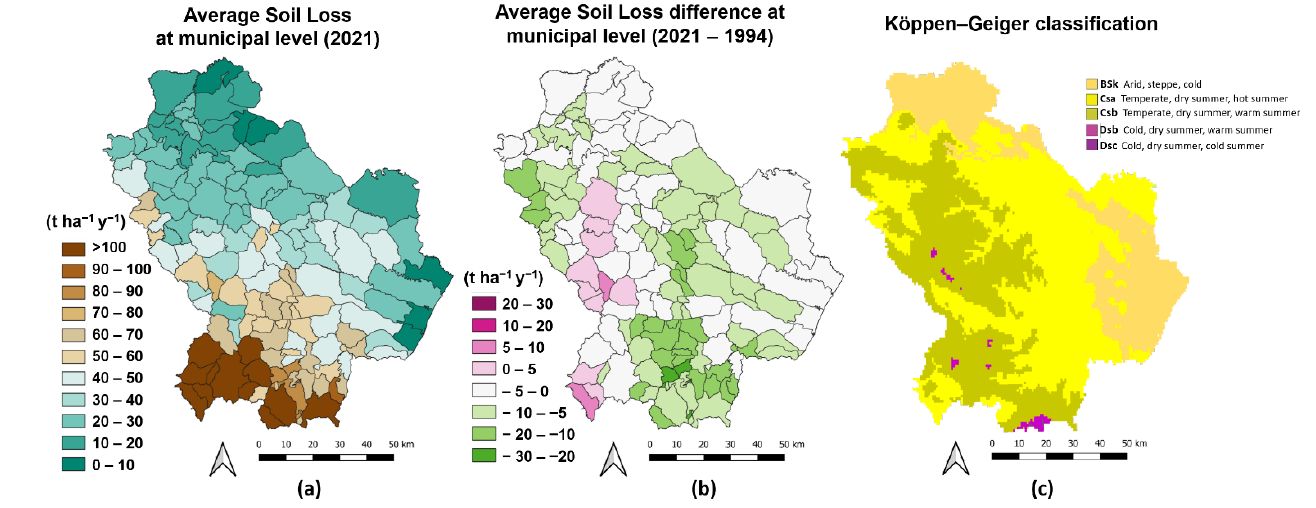
Figure 8. Soil loss rates computed at the municipal level for: ( a ) 2021; ( b ) soil loss difference 2021–1994; ( c ) Köppen–Geiger classification of climates.